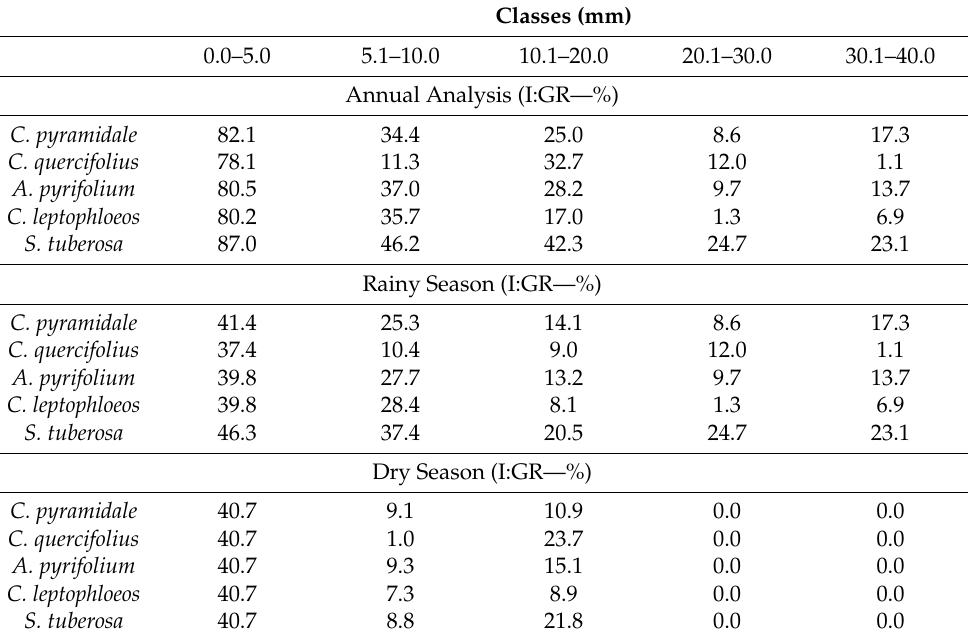
Table 4. Proportions of gross rainfall portioned into interception (I:GR) considering five rainfall